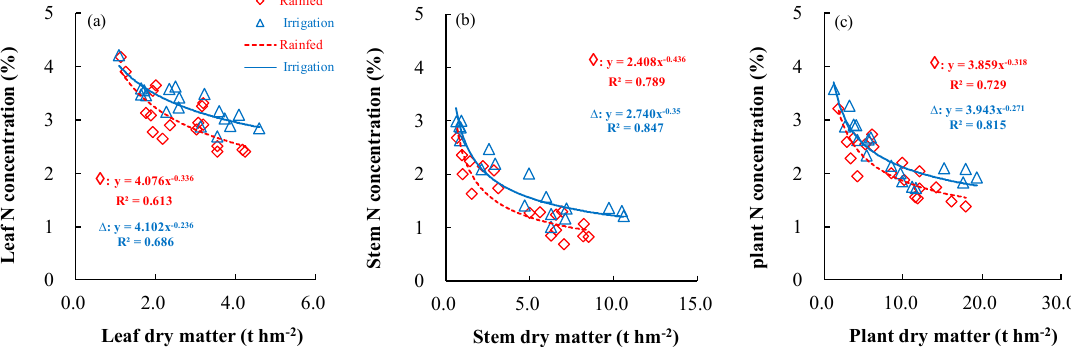
Figure 3. Critical N concentration dilution curves in wheat leaves, stems, and the whole plant under different irrigation conditions in Zhengzhou. The datasets are from Exp. 1 and 2.